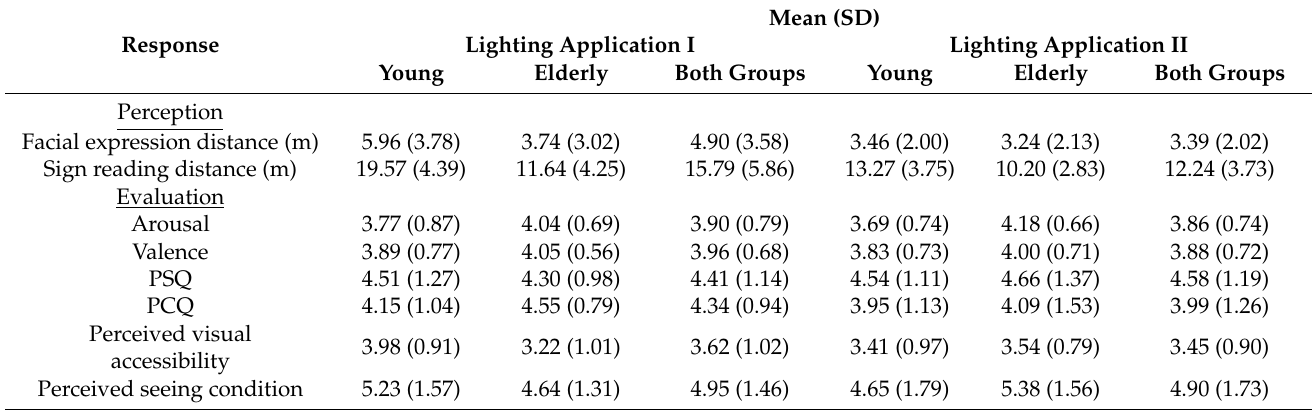
Table 3. Mean values for all measures sorted by lighting application and age group.